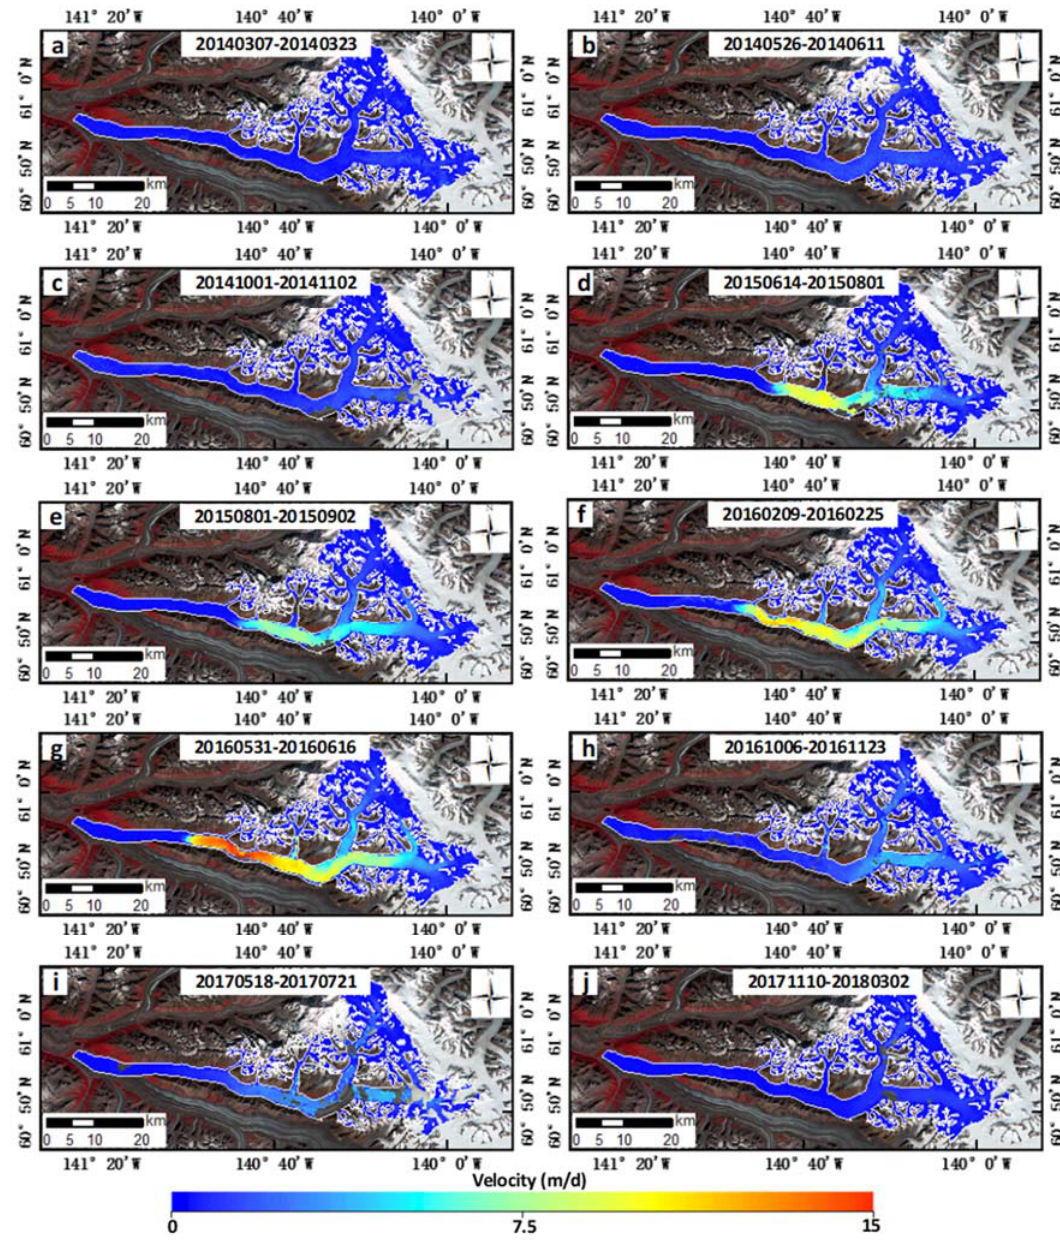
Figure 3. Selected velocity detail maps from March 2014 to March 2018 derived from Landsat 8 images, highlighting the seasonal fluctuations of glacier velocity associated with the surge. The velocity maps overlay the Landsat 8 image (bands 5, 4 and 3, combined) of Walsh Glacier on 11 August 2013.